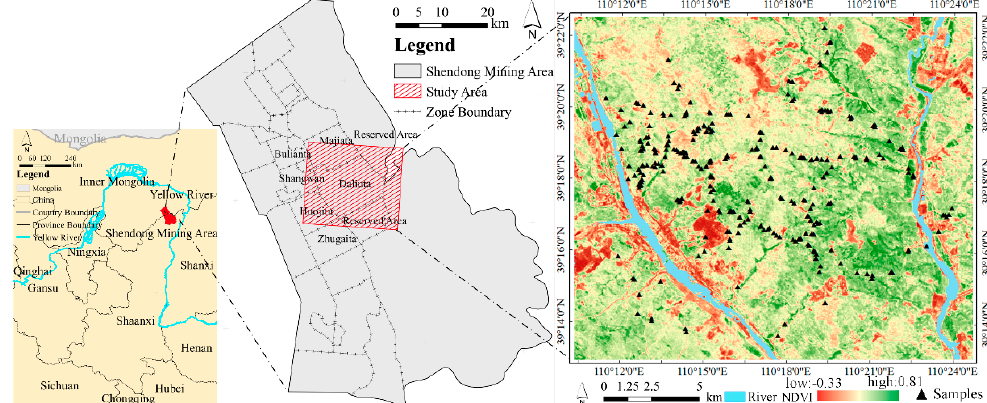
Figure 4. Location of the study area in the Shendong mining area. The NDVI was calculated using Landsat imagery (30 July 2017). The black triangle shows the location of field investigation samples.